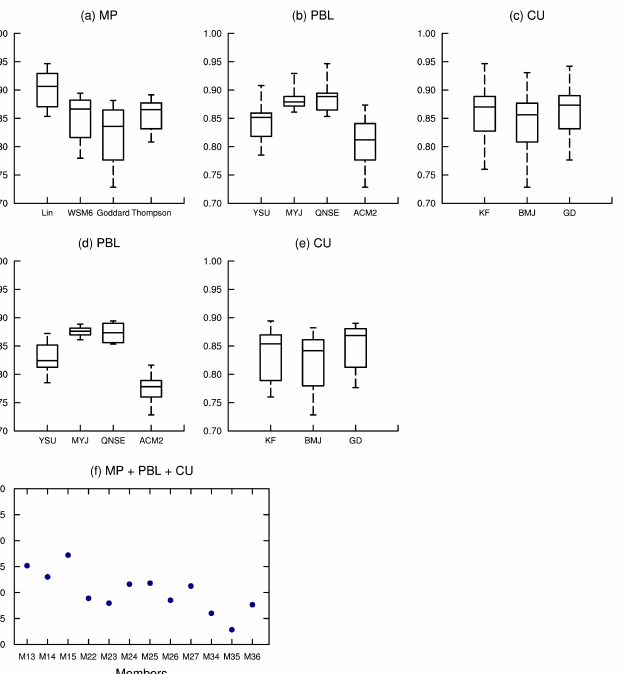
Figure 12. Same as Figure 10, but for all 24 h. The second row retains only those members with WSM6 and Goddard MP schemes, and the third row additionally excludes those members containing MYJ and QNSE PBL